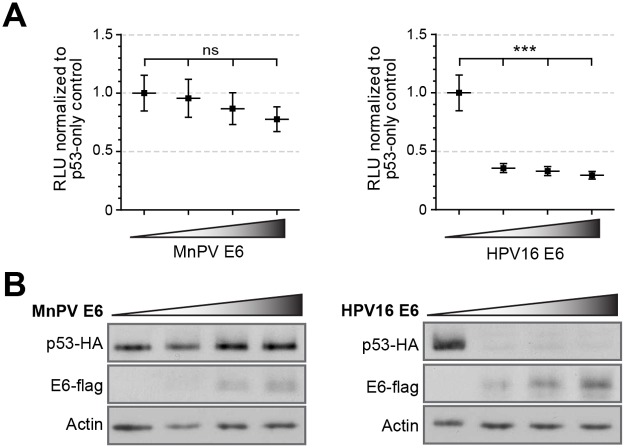
Transactivating capacity of Mastomys p53 in the presence of MnPV E6.A) The capacity of p53 to transactivate a p53-responsive firefly luciferase gene measured in H1299 cells transfected with reporter plasmids and expression vectors for Mastomys p53 and MnPV E6 or human p53 and HPV16 E6 as a control. Transactivation activity was measured by luminescence (RLU, relative light units). Cells transfected only with p53 served as control and their RLU levels were arbitrarily set to 1 (Mean ± SEM; n = 7; 1way-ANOVA, ***p<0.0001). B) Western blots showing protein levels of p53 and E6 in the lysates of the transactivation assay. Actin served as an internal loading control.